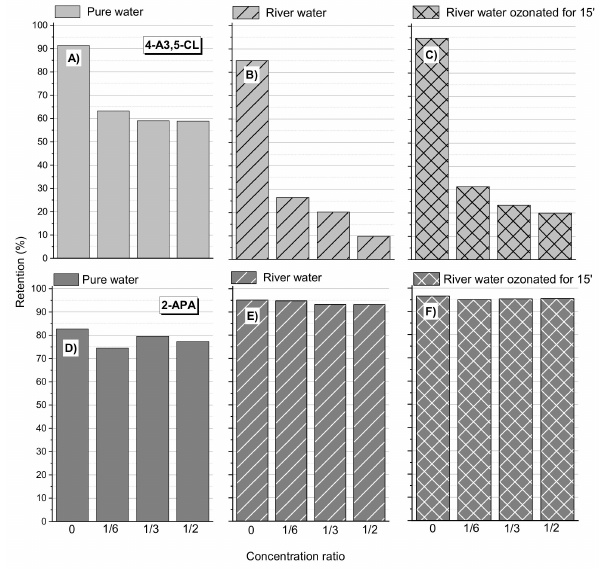
Figure 4. The influence of the water matrix on the retention of DCF oxidation products: ( A ) 4- Amino-3,5-dichlorofenol (4-A3,5-Cl) in pure water; ( B ) 4-A3,5-Cl in river water; ( C ) 4-A3,5-Cl in river water ozonated for 15 min (ozone dose in the gas phase: 31.5 mg O 3 per L of water); ( D ) 2- Aminophenylacetic acid (2-APA) in pure water; ( E ) 2-APA in river water; ( F ) 2-APA in river water ozonated for 15 min (ozone dose in the gas phase: 31.5 mg O 3 per L of water); membrane HL, pressure 1.0 MPa, 30 ◦ C. See Table 1 for the composition of the river water